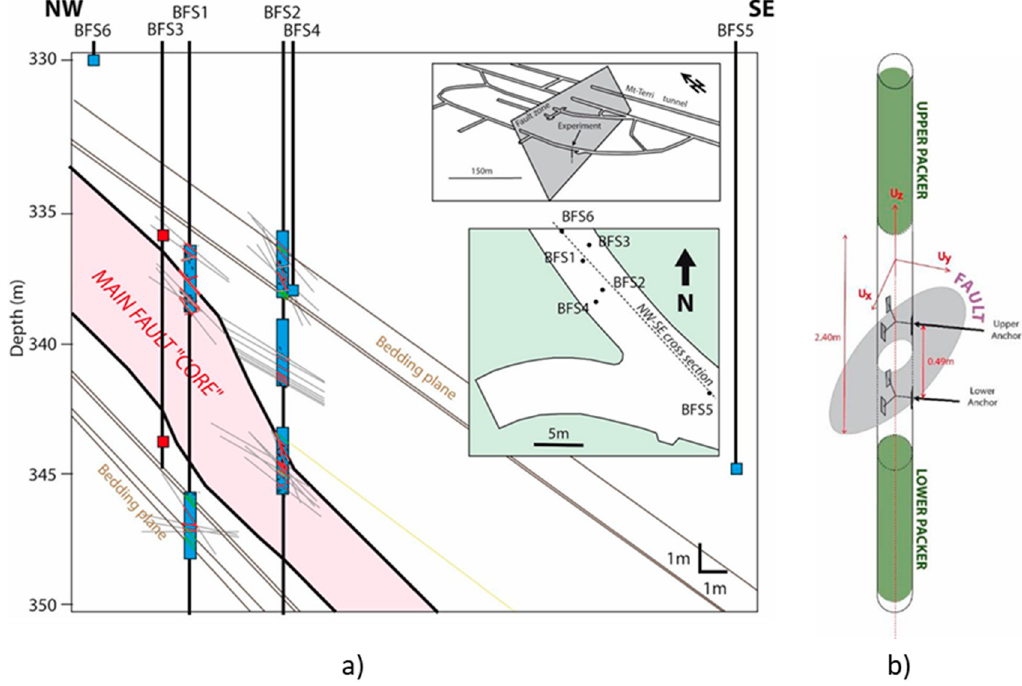
Figure 2. Cross Section along Main Fault and the secondary faults showing the location of the packed- off injection chambers. The packed-off intervals are equipped with the HPPP apparatus, which measures relative displacements in three directions. Seismic events are also measured at the locations shown in red. ( a ) Geological section through the Main Fault and secondary faults. ( b ) Packed-off section.